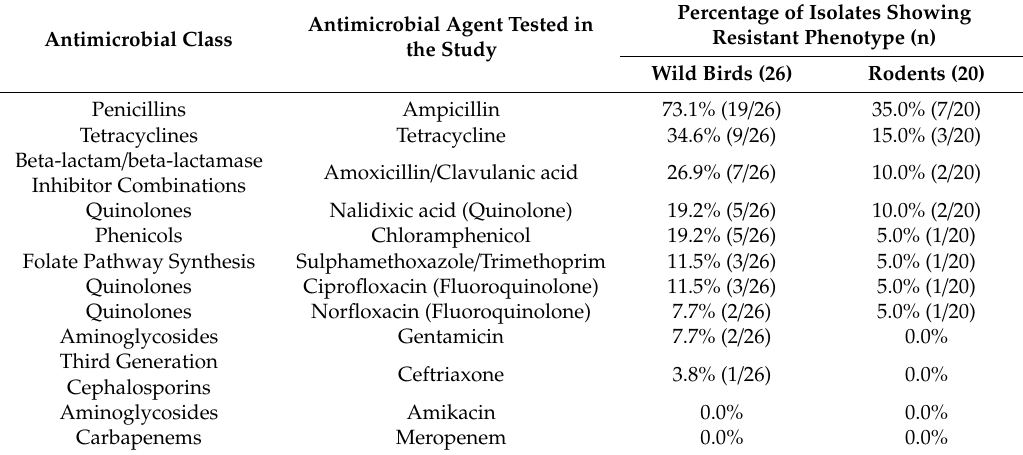
Figure 1. Percentage of antimicrobial resistance in E. coli isolates from wild birds and rodents (Corresponding to Table 4). Antimicrobial agents used for testing were AK: Amikacin; AMC: Amoxicillin/Clavulanic acid; AMP: Ampicillin; C: Chloramphenicol; CIP: Ciprofloxacin; CN: Gentamicin; CRO: Ceftriaxone; MEM: Meropenem; NA: Nalidixic acid; NOR: Norfloxacin; SXT: Sulphamethoxazole/Trimethoprim; TE: Tetracycline. Table 4. Percentage of antimicrobial resistance in E. coli isolates from wild birds and rodents (Corresponding to Figure 1).